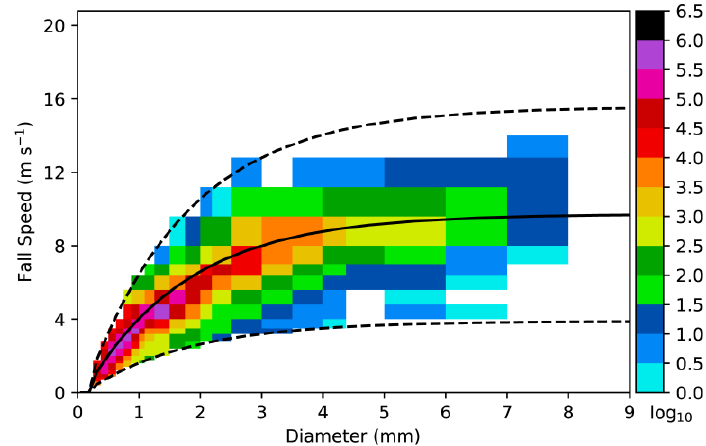
Figure 3. Scattergram of raindrop size distribution (DSD) at different diameter size and fall velocity classes after QC for the entire experiment period. The solid curve indicates the empirical 𝑉 – 𝐷 relationship described by Atlas et al. [40] which considers the air density effect; dashed curves indicate the ±60% ranges of the empirical 𝑉 – 𝐷 relationship.